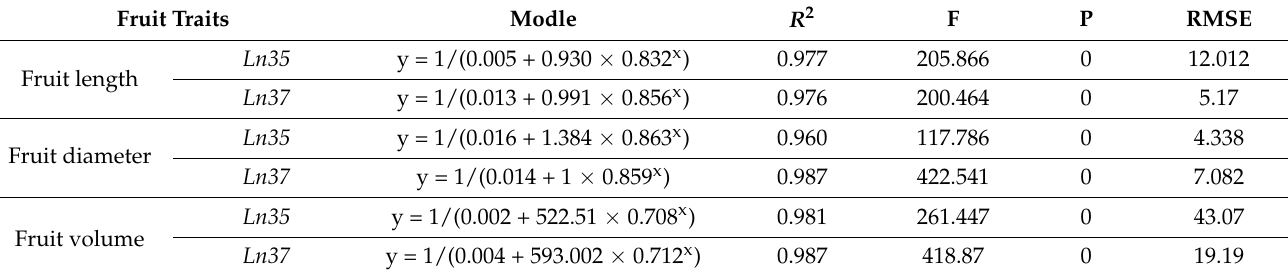
Figure 5. Relationship between fruit shape and TEP under Ln35 and Ln37 . ( A ) is the model of fruit length in Ln35 ; ( B ) is the model of fruit diameter in Ln35 ; ( C ) is the model of fruit length in Ln37 ; ( D ) is the model of fruit diameter in Ln37 . Table 3. Logistic regression equations of fruit shape for two inbred